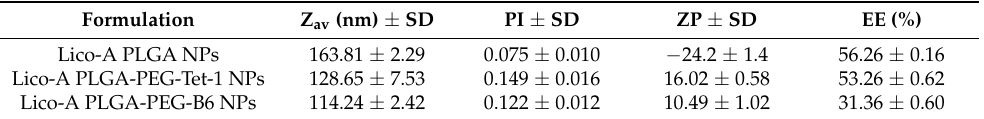
Table 3. Physicochemical parameters of the optimized formulation (1 mg/mL of Lico-A, 8 mg/mL of PLGA, and 0.4%Tween 80) without peptide addition, with PEG and Tet-1 peptide, and with PEG and B6